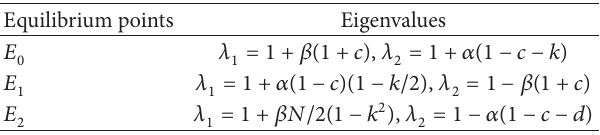
Table 1: The eigenvalues of the Jacobian matrix (14) evaluated at the boundary equilibrium